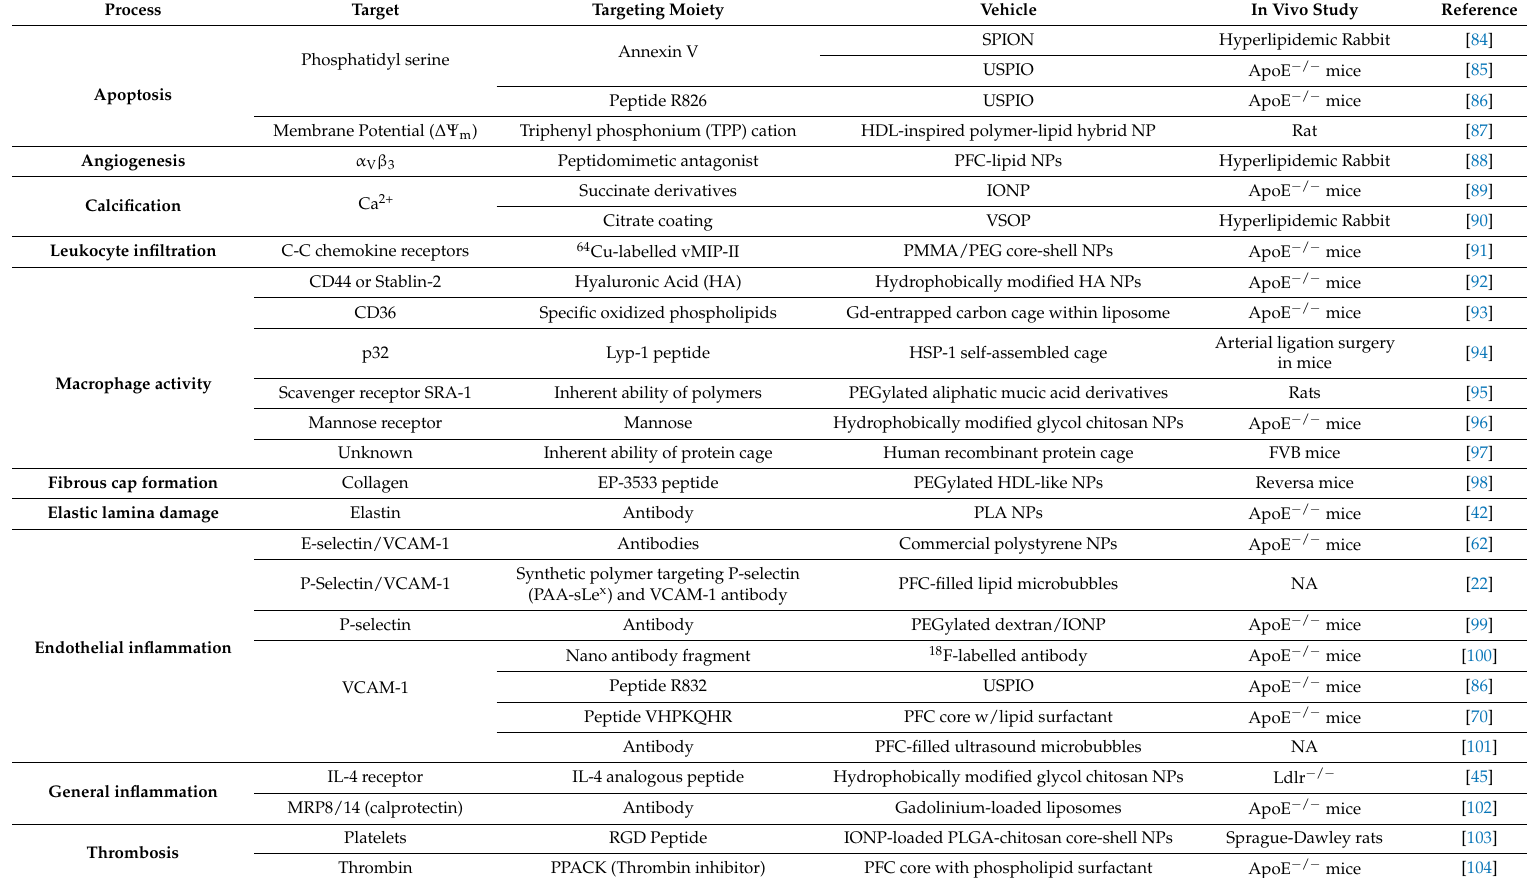
Table 2. A non-exhaustive list of targets recently identified through various NP-mediated targeting of atherosclerosis, mainly for imaging